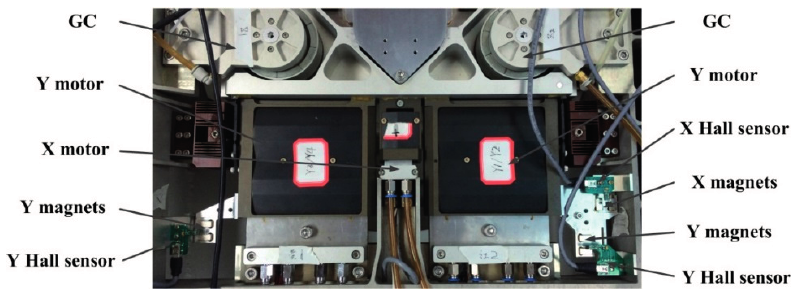
Figure 13. Three DOFs displacement measurement system installed on reticle stage of the lithography.